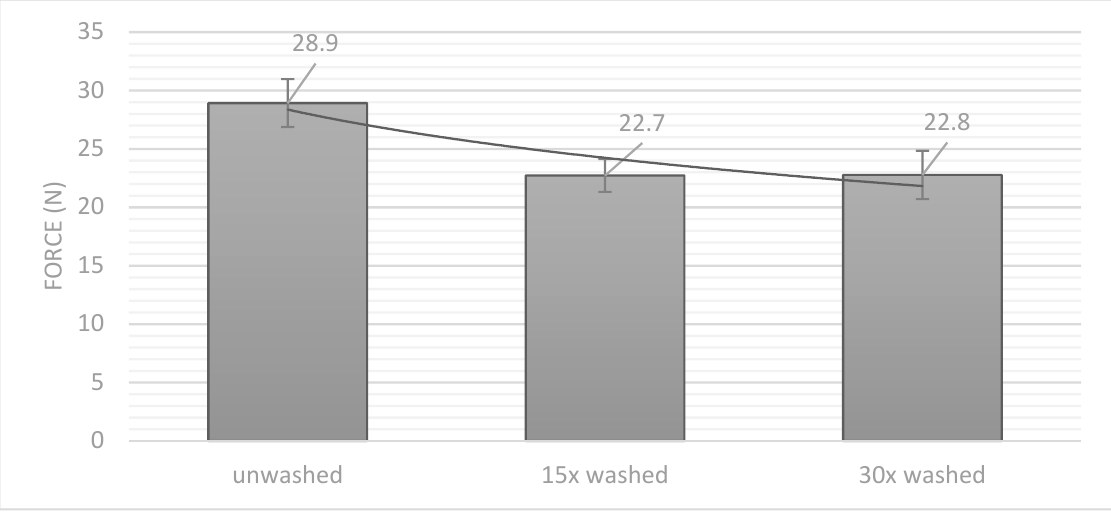
Figure 9. Peeling strength force after different washing cycles (black exponential trend line).